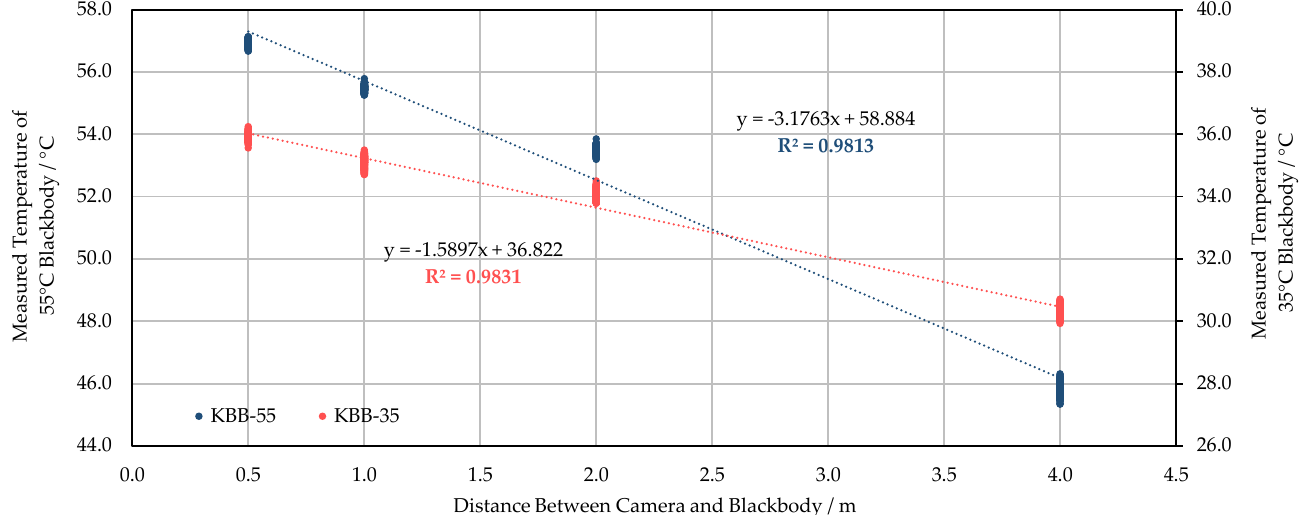
Figure 10. The correlation between the temperature observations measured by FLIR E8-XT and the measuring distance at the blackbody temperature of 35 °C and 55 °C.